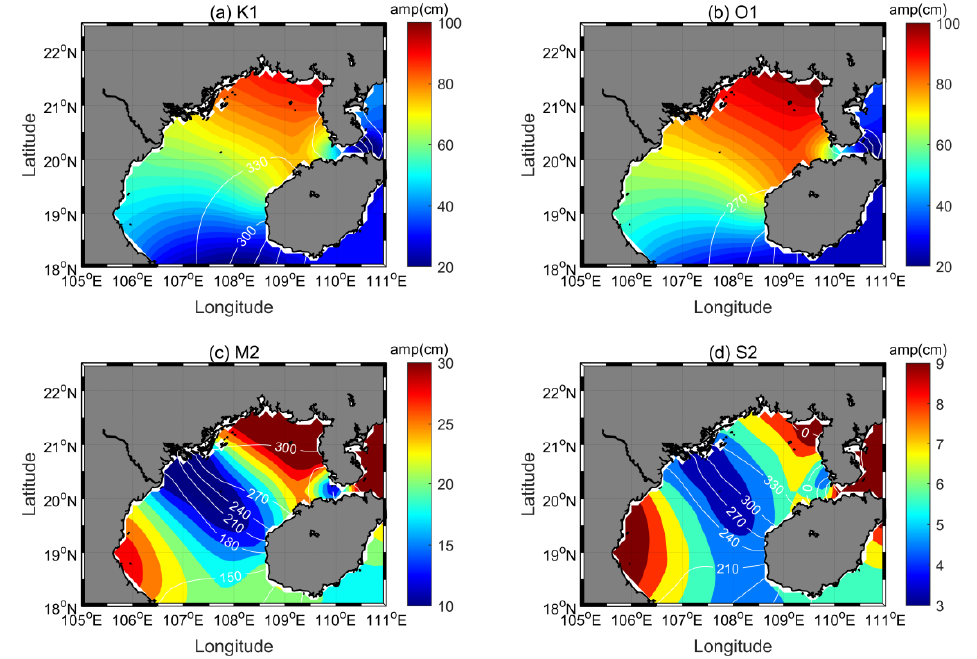
Figure 1. Cotidal charts for ( a ) K 1 , ( b ) O 1 , ( c ) M 2 , and ( d ) S 2 constituents in the Gulf of Tonkin calculated from EOT20 model. The amplitudes are indicated by color. The white lines are Greenwich phases spaced at intervals of 30°.